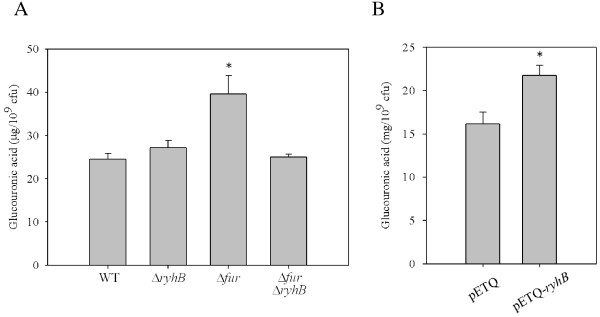
RyhB activates CPS biosynthesis. (A) Comparison of CPS levels in WT, ΔryhB, Δfur, and ΔfurΔryhB strains. Bacterial strains were grown in LB medium at 37°C with agitation. After 16 h of growth, the bacterial glucuronic acid content was determined. *, P < 0.001 compared with WT. (B) WT strains carrying the vector control (pETQ) or pETQ-ryhB were grown in LB with 100 μM IPTG to induce ryhB expression. *, P < 0.001 compared with WT strains carrying pETQ.